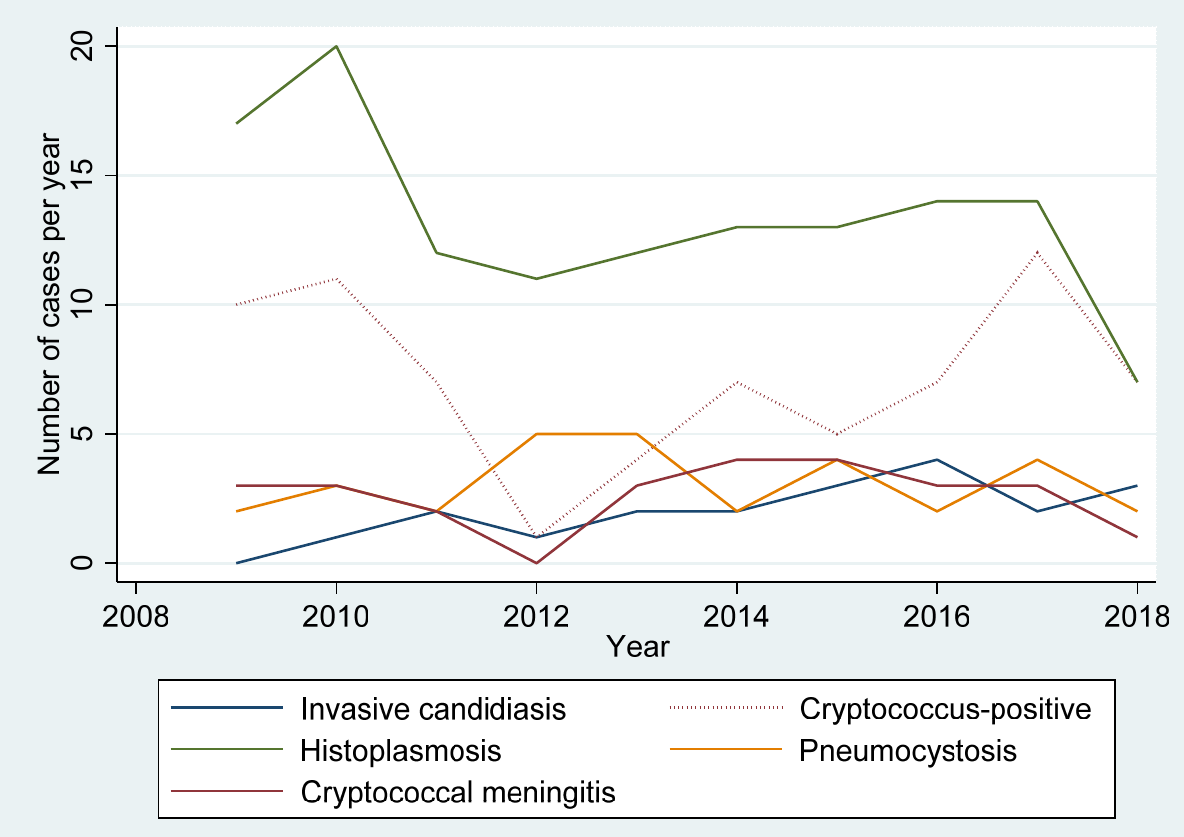
Figure 1. Temporal trends of invasive fungal infections in HIV from 2009 to 2018.